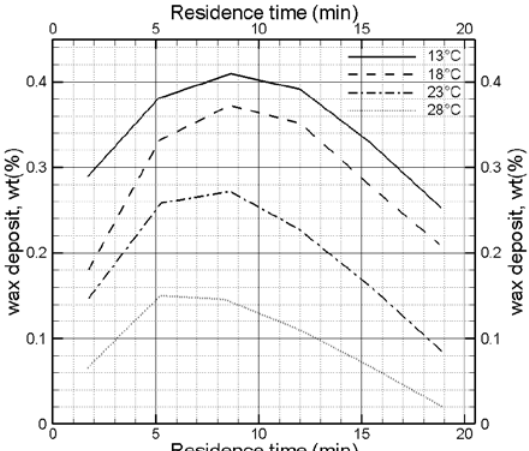
Figure 14 Effect on wax deposition due to residence time at 200 ml/min (Kelechukwu et al., 2010)